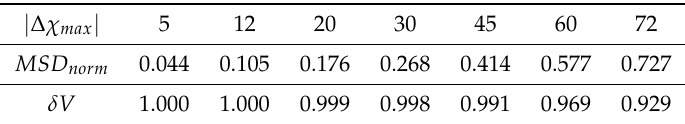
Table 1. Normalized minimum stabilization distances and velocity correction factors as functions of | ∆ χ max | for fly-by states.